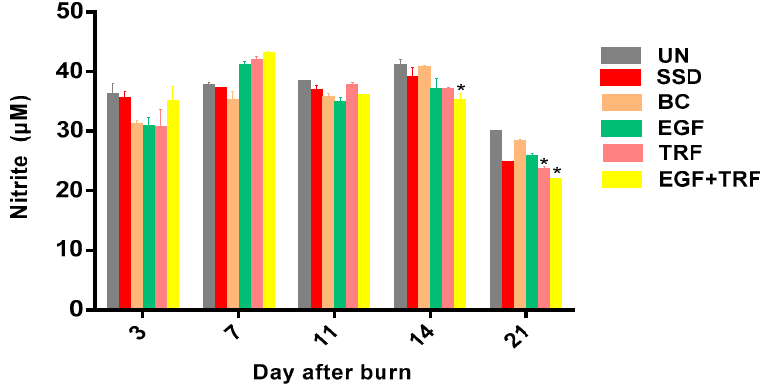
Figure 8. Nitrite content in all the groups over time post-burn. Data were expressed as mean ± S.D. * p < 0.05 compared with those of the UN group on the respective day.